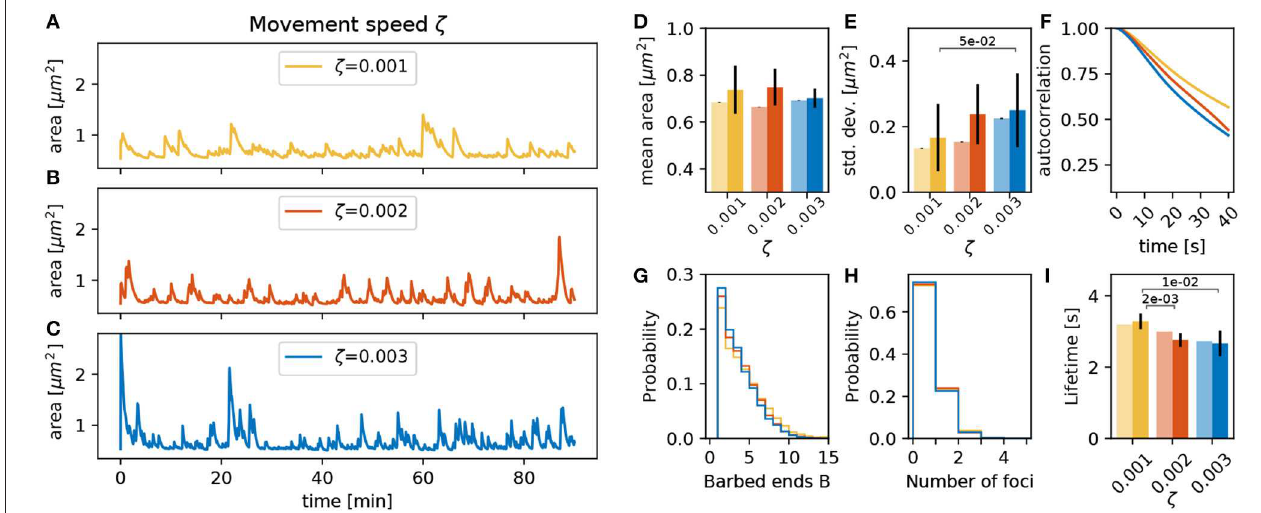
FIGURE 7 | Varying the movement speed ζ . (A–C) Evolution of the spine head area over time for different values of ζ : (A) ζ ζ 0.003. (D) Temporal mean of the spine head area. Light bars correspond to values from single 90 min simulations (standard deviations obtained from 50-fold = bootstrap). Full colored bars and errors correspond to the mean and standard deviation over fifteen 15 min simulations. (E) Standard deviation of the spine head area over time. The p -value for significant Welch-tests is indicated. (F) Autocorrelation functions for the area fluctuations in the 90 min simulations. (G) Relative frequency of the mean number of barbed ends per focus over all simulation time-steps in (A–C) . (H) Relative frequency of the number of actin polymerization foci. (I) Mean lifetime of a focus.